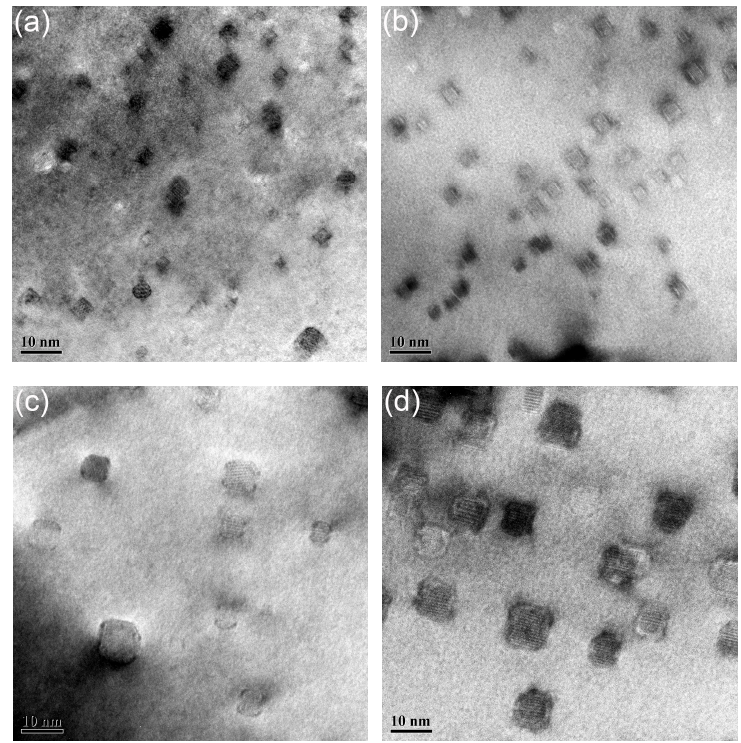
Figure 12. Distribution of nanoparticles in the samples deformed with the strain rate of 0.01 s − 1 at ( a ) 1050 ° C; ( b ) 1100 ° C; ( c ) 1150 ° C; ( d ) 1200 ° C.